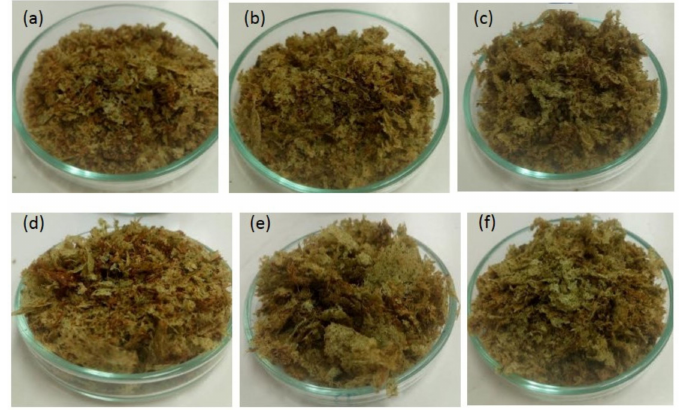
Figure 2. Images of the dehydrated product obtained in di ff erent conditions, according to Table 1. ( a ) Run 1, ( b ) run 2, ( c ) run 3, ( d ) run 4, ( e ) run 5, and ( f ) run